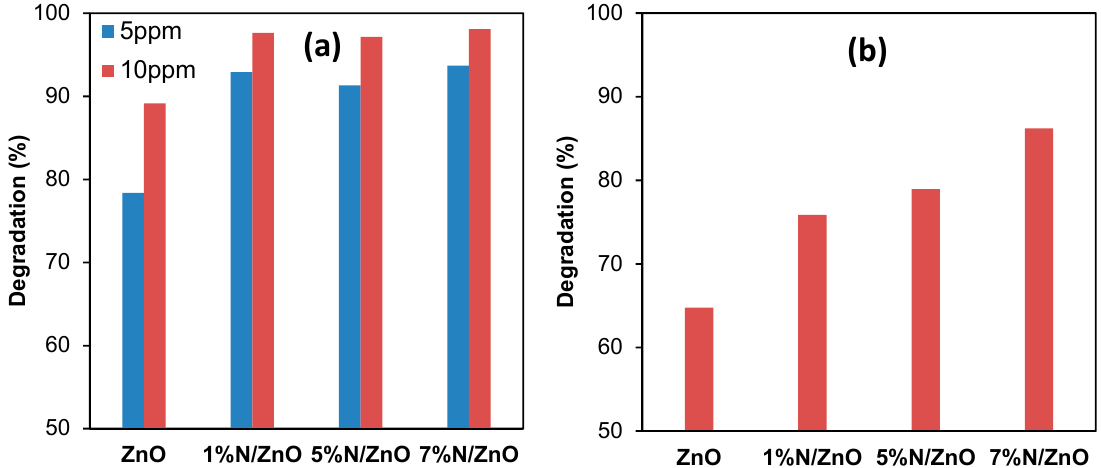
Figure 6. Percentages of photocatalytic degradation after 3 hours’ sunlight irradiation for ( a ) MB and ( b ) RhB dye.